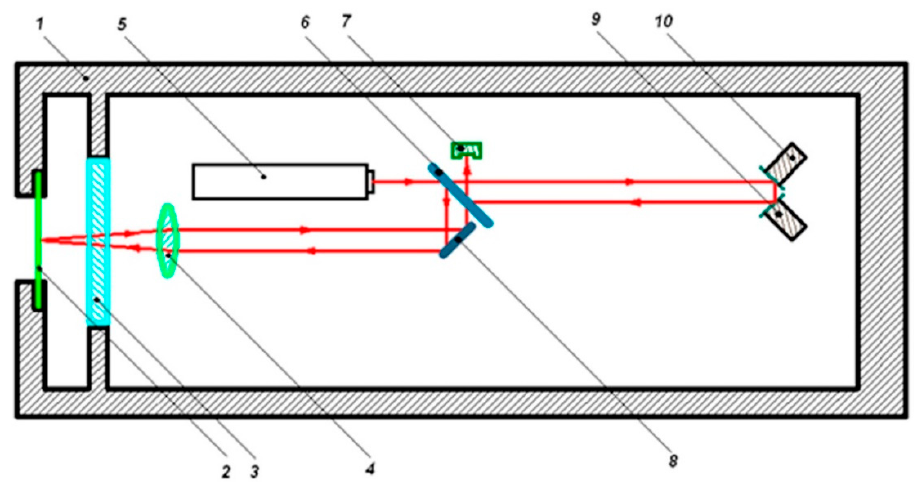
Figure 3. Optical scheme. 1—housing, 2—membrane with a mirror fastened to its the center, 3—optical window, 4—lens, 5—laser, 6—plane-parallel plate dividing plate, 7—photodetector, 8—adjustment reflective mirror, 9—buildup piezoceramics with reflective mirror, 10—compensation piezoceramics with reflective mirror.